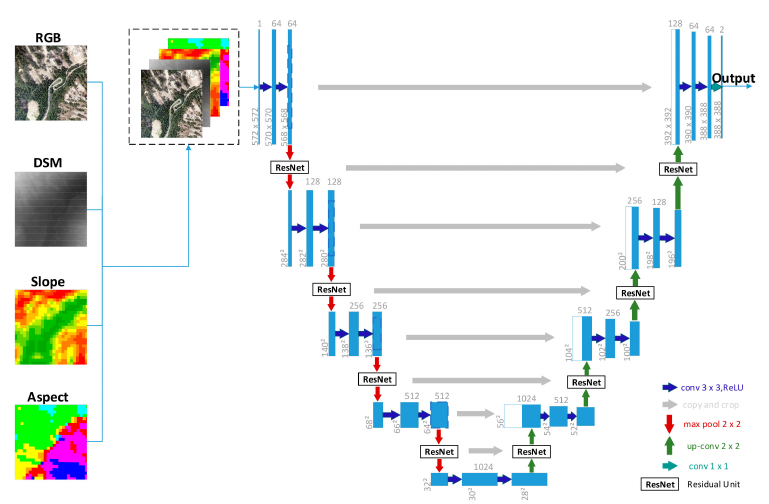
Figure 3. Structure of the improved U-Net network.